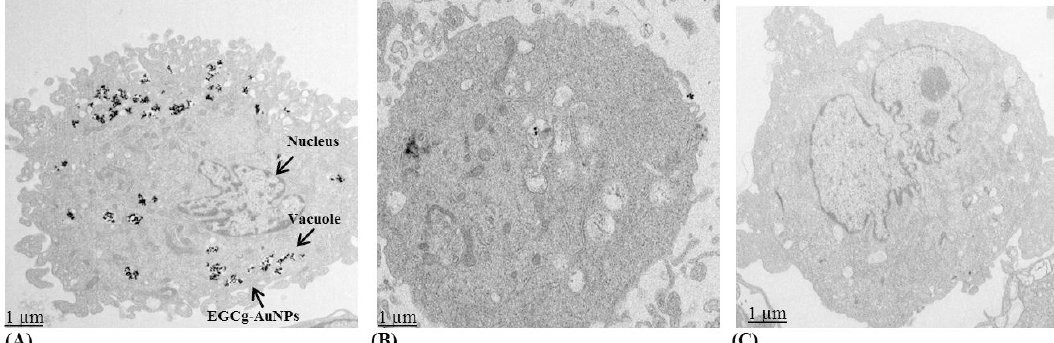
Figure 4. Cellular internalization of gold nanoparticles in HUVECs: ( A ) cells treated with GCg-AuNPs (50 μ g/mL), 2 h; ( B ) cells pretreated with laminin receptor blocking antibody (ABLR), then treated with EGCg-AuNPs (50 μ g/mL), 2 h; ( C ) cells treated with starch functionalized gold nanoparticles (50 μ g/mL), 2 h; images were captured by transmission electron microscopy. HUVECs (human umbilical vein endothelial cells).